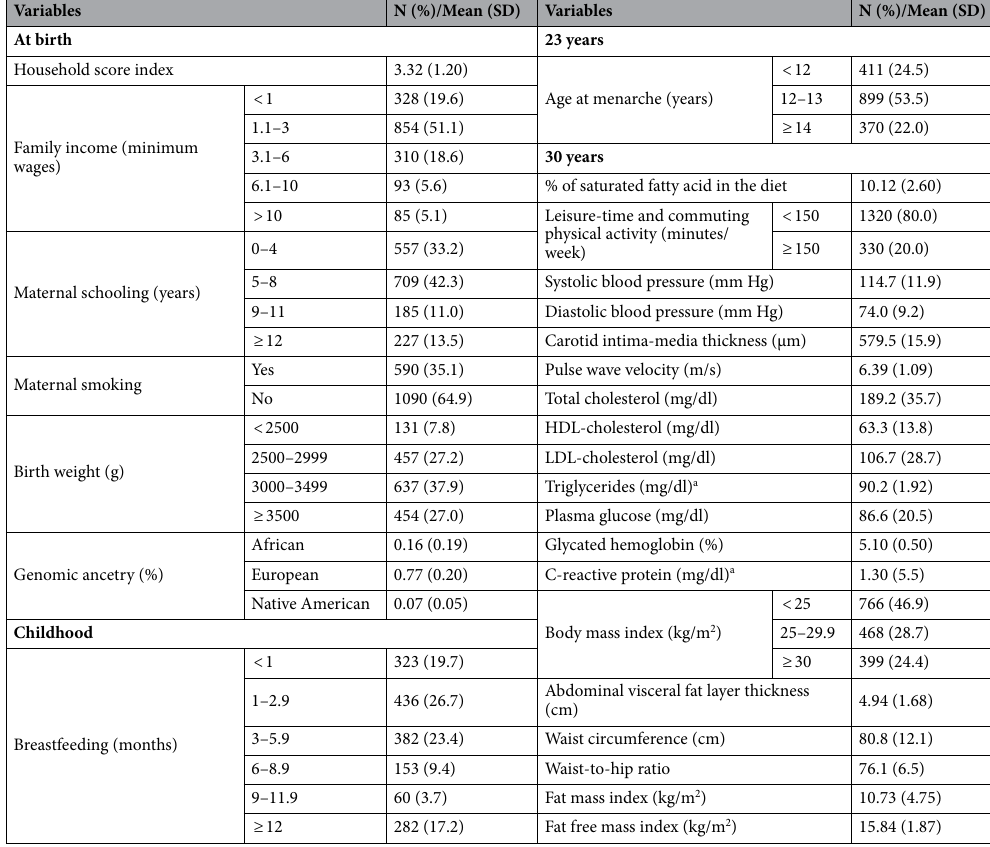
Table 1. Characteristics of the study population. a Geometric mean and Interquartile